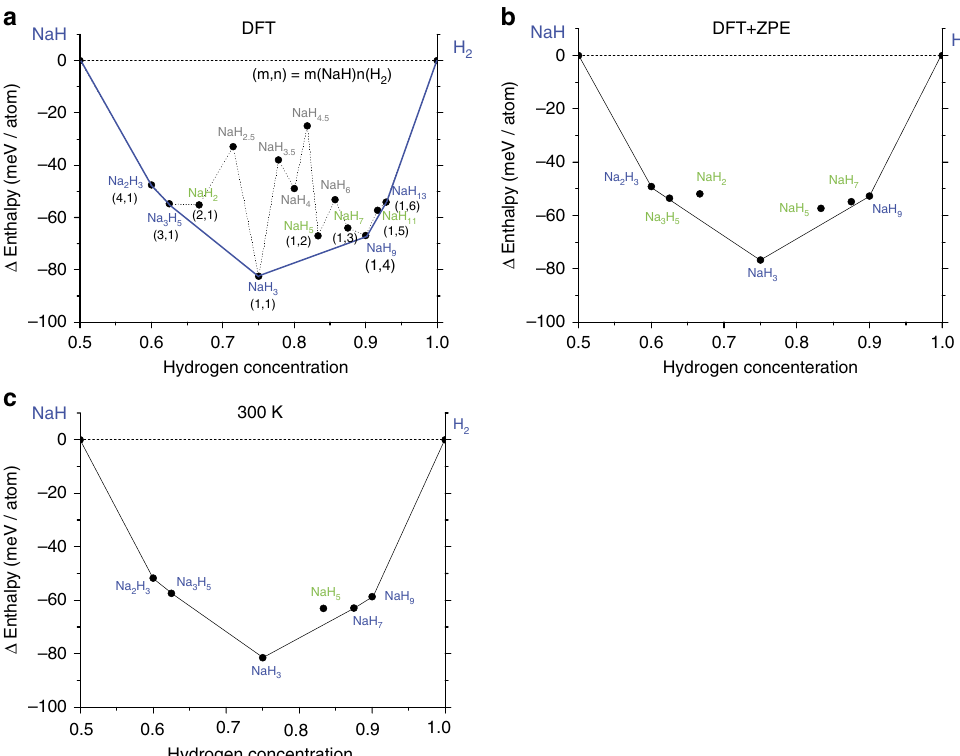
Figure 1 | Calculations of stable sodium polyhydride compounds. Convex hull curve of Na–H compounds at 50GPa with respect to the decomposition (horizontal dashed line) into NaH and H 2 using ( a ) density functional theory (DFT) ( b ) including ZPE and ( c ) including temperature (300K). The chemical formula in blue (green) shows predicted stable (metastable) compounds. The (m,n) correspond to compositions in units of NaH and H 2 , respectively. Chemical formulas in black are found to be stable against the decomposition into NaH and H 2 , however, they possess relatively high total energy compared to other stable (meta-stable)